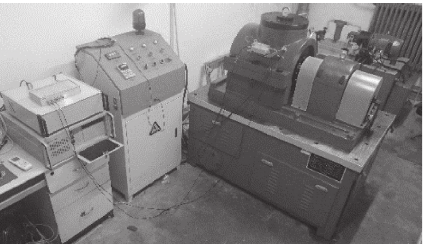
Figure 8: Metro traction motor bearing information acquisition system.